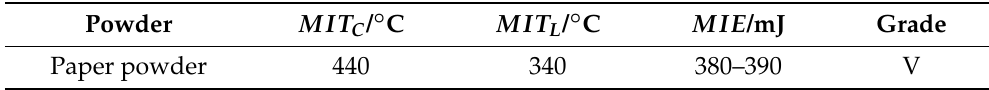
Table 13. Experimental data on dust explosion sensitivity.